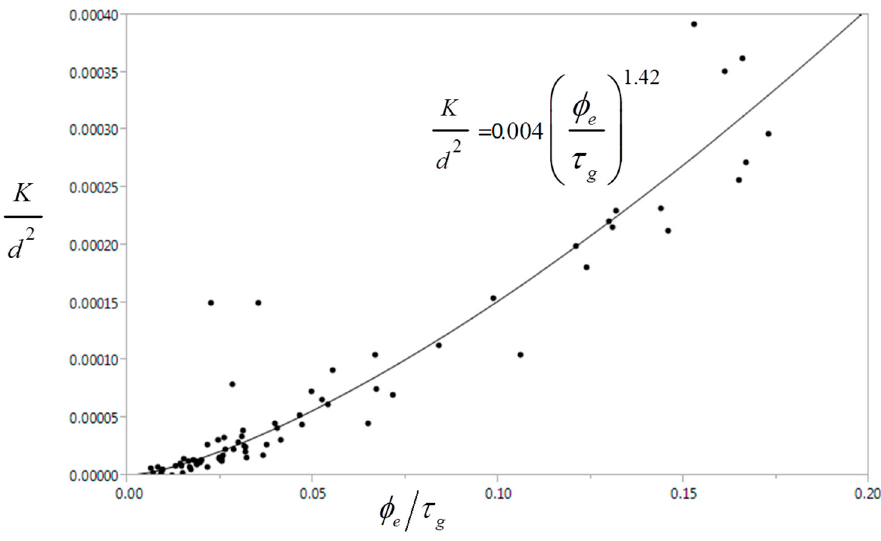
Figure 11. A non-dimensional model for microstructure-transport property correlation.